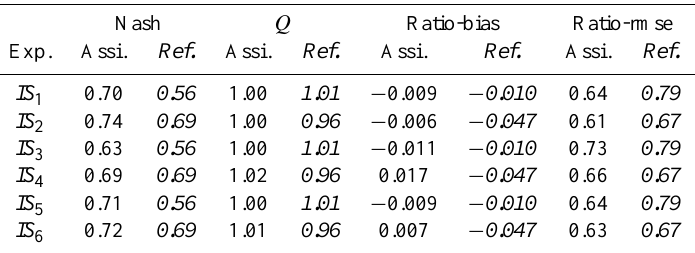
Table 4. Statistical scores for SIM discharges and the BLUE assimilation system for a set of 49 independent stations. Scores are averaged over a 19-month period (10 March 2005–30 September 2006). Nash, Q , Ratio-bias and Ratio-rmse scores are presented for each assimilation experiment (straight) and its corresponding reference simulation ( italics ). Nash Q Ratio-bias Ratio-rmse Exp. Assi. Ref. Assi. Ref. Assi. Ref. Assi. Ref. IS 1 0.70 0.56 1.00 1.01 − 0.009 − 0.010 0.64 0.79 IS 2 0.74